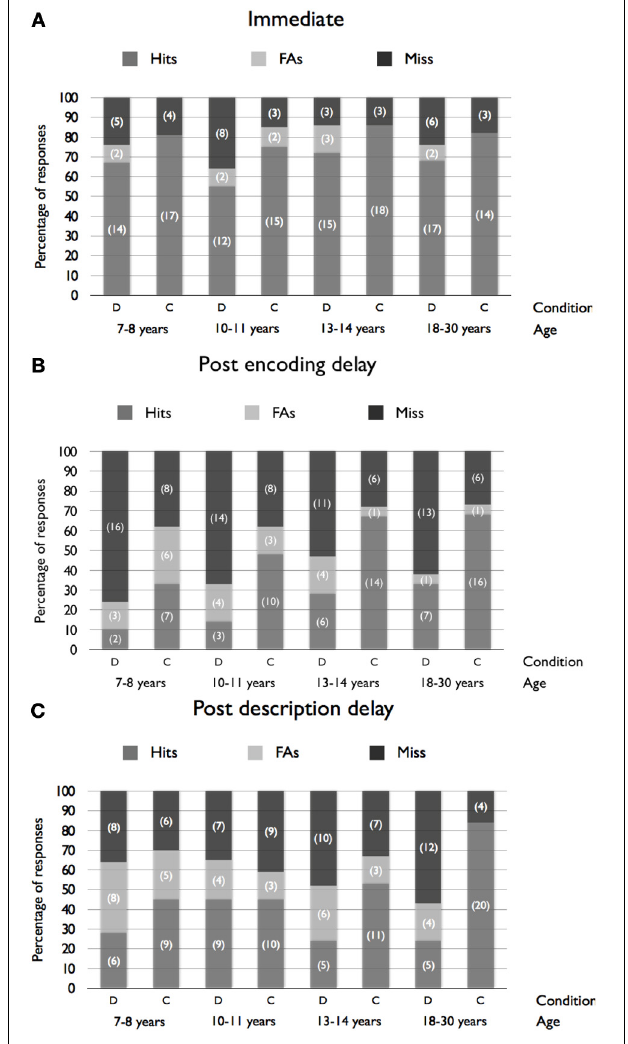
FIGURE 1 | Percentages of hits, false alarms (FAs) and miss responses as a function of Age and Condition for the immediate (A), postencoding delay (B) and postdescription delay (C) conditions (frequencies are presented in